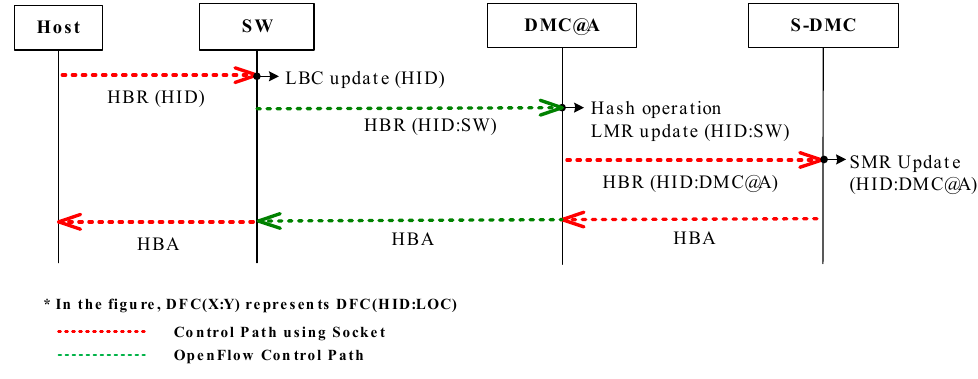
Figure 4. HID–LOC binding operations.